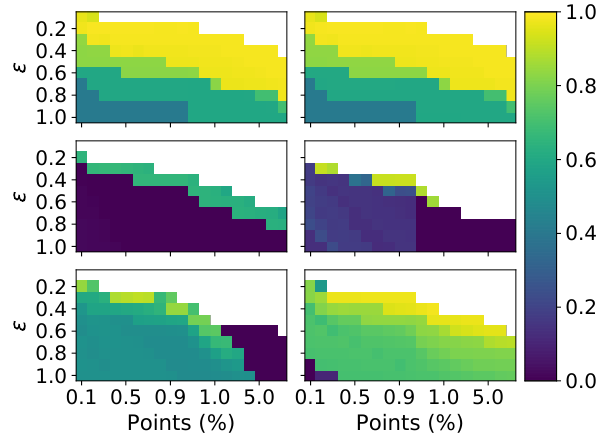
Figure 14. Adjusted rand score for DBSCAN, over a range differ- ent values of (cid:15) and minimum number of points required to form a neighbourhood. The minimum number of points is expressed rela- tive to the total number of points. The columns correspond to 3 and 9 σ , respectively. The rows correspond to the PSL, 2008 and 2014 data, respectively.